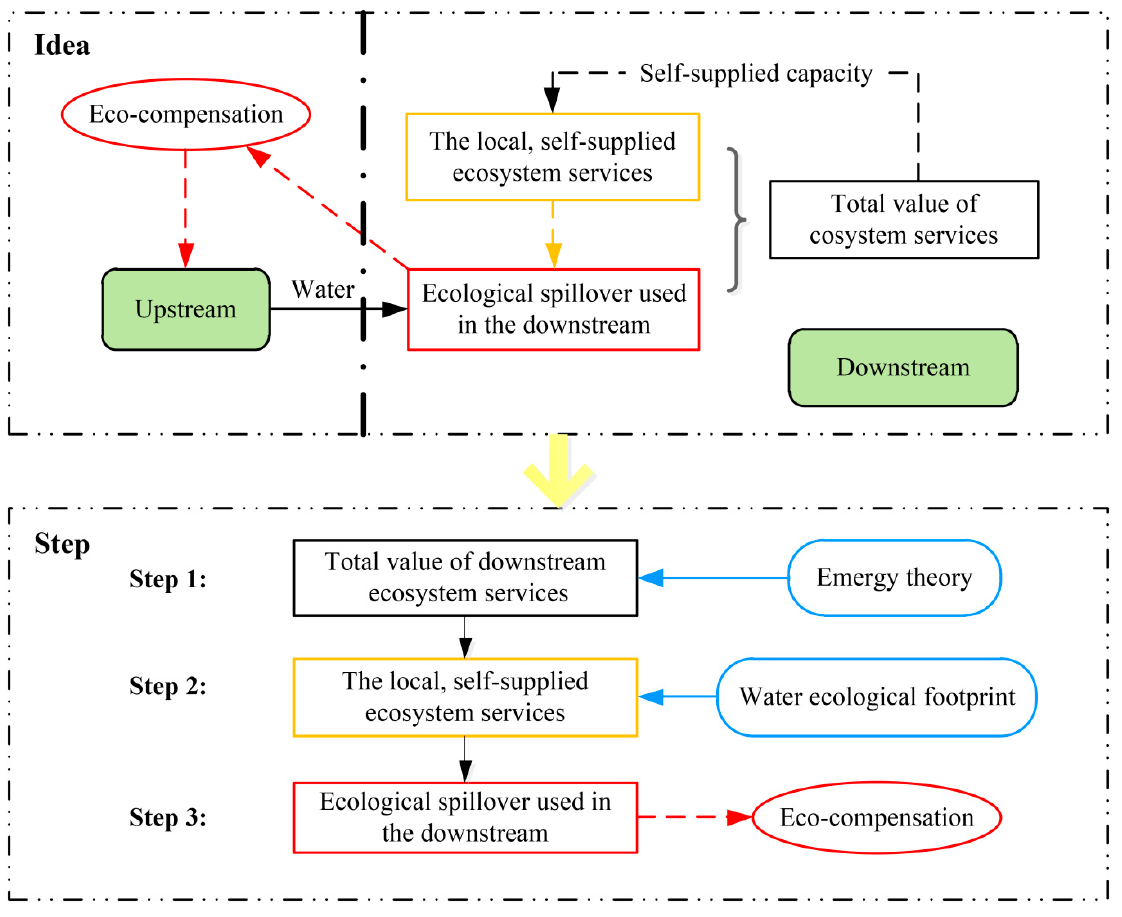
Figure 1. Conceptual framework for quantifying eco-compensation based on both upstream-to-downstream flowing ecological spillover and the local, self-supplied ecosystem services in the downstream.